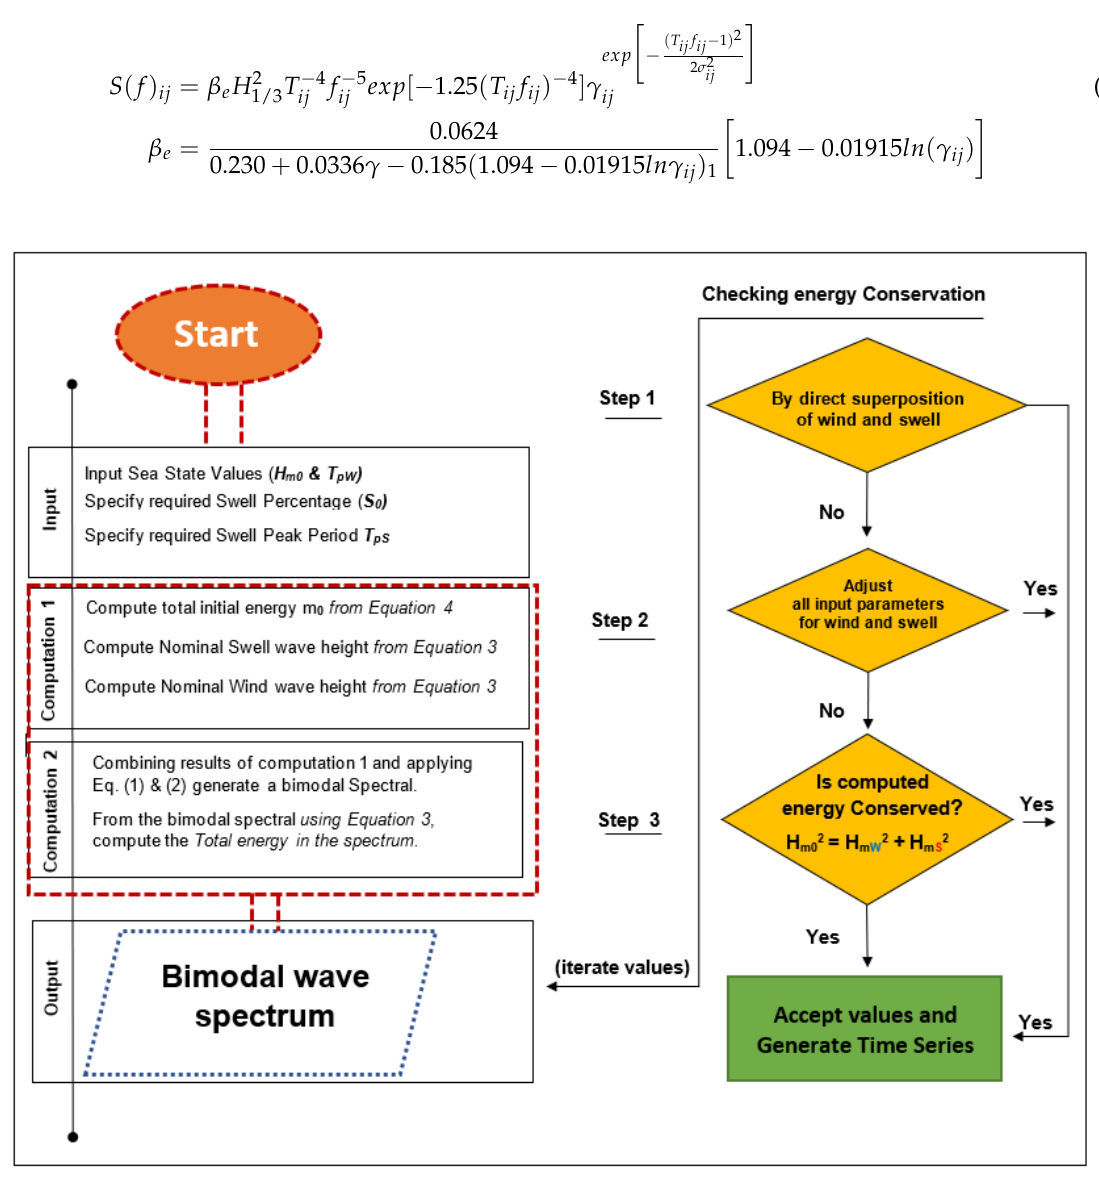
Figure 1. Flow chart on the generation of an energy conserved bimodal